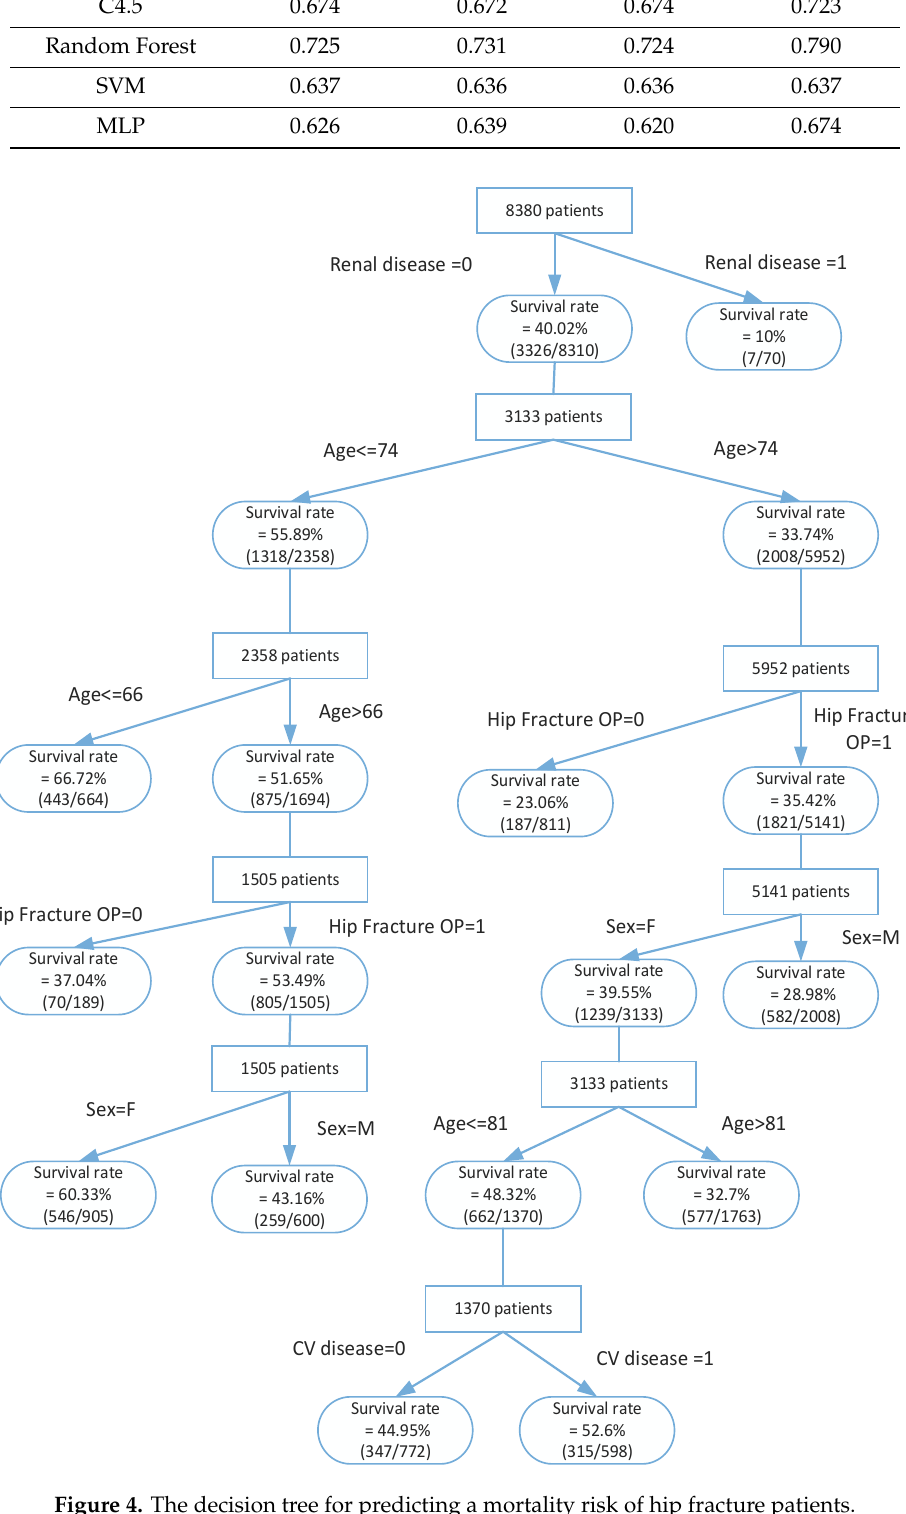
Figure 4. The decision tree for predicting a mortality risk of hip fracture patients.